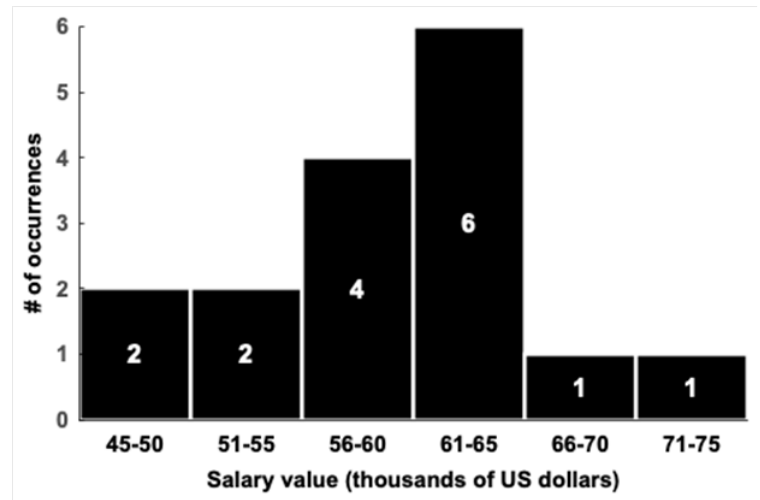
Figure 2 : Histogram of salary values for positions that gave a quantitative value ( n = 16). If a salary range was given, the median salary was used. If two salary levels were listed, the lower level was